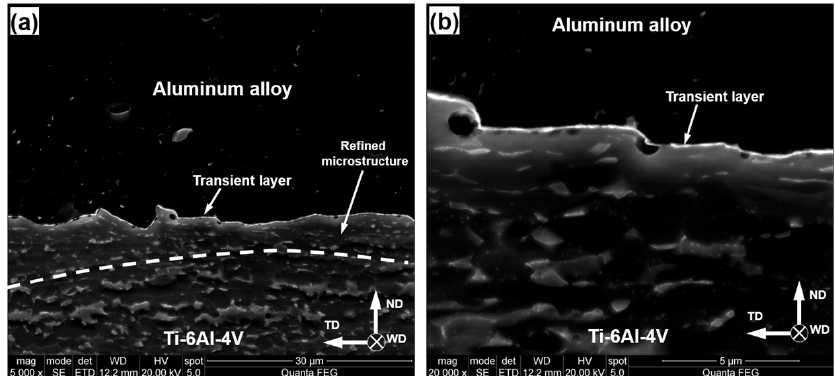
Figure 4. Typical SEM micrographs of welded surface (etched condition): ( a ) low-magnification image, ( b ) high-magnification image. ND, TD, and WD are normal direction, transverse direction, and welding direction, respectively. Note: the beta phase in Ti–6Al–4V appears bright. Note 2: The SEM micrographs were taken from the welded joint of AA6013 alloy produced at the welding speed of 76.2 mm/min.